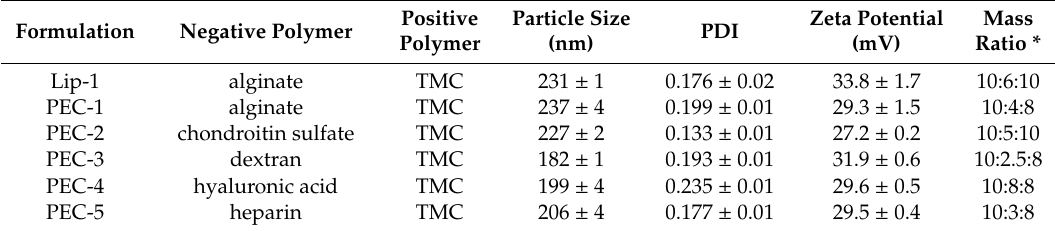
Table 1. Physicochemical characterization of LCP-1 loaded